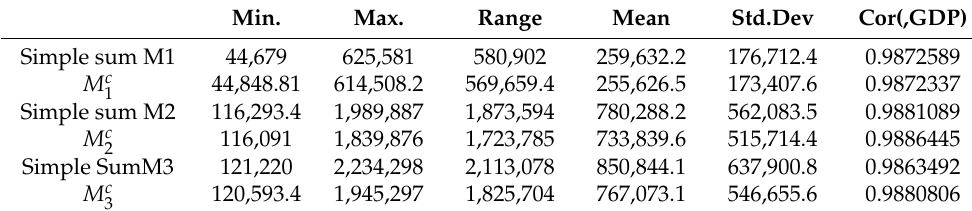
Table 3. The data summary for different monetary aggregates (2000–2020). Min. Max. Range Mean Std.Dev Cor(,GDP)